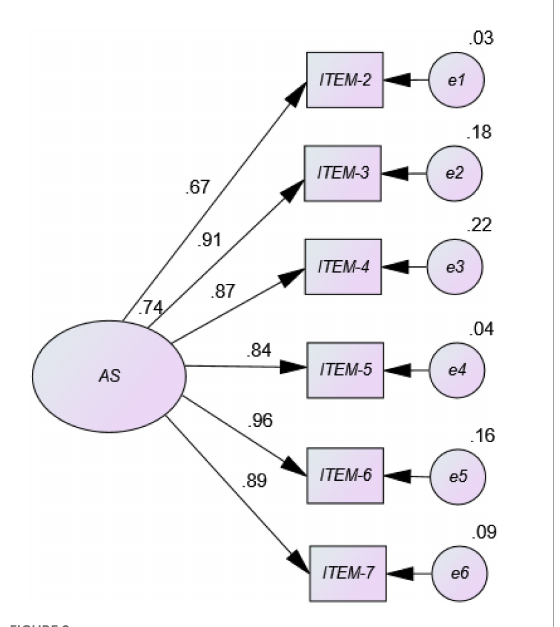
FIGURE2 Path diagram of the unidimensional model corresponding to AS in Spanish university students (Model 2 = eliminating item 1).